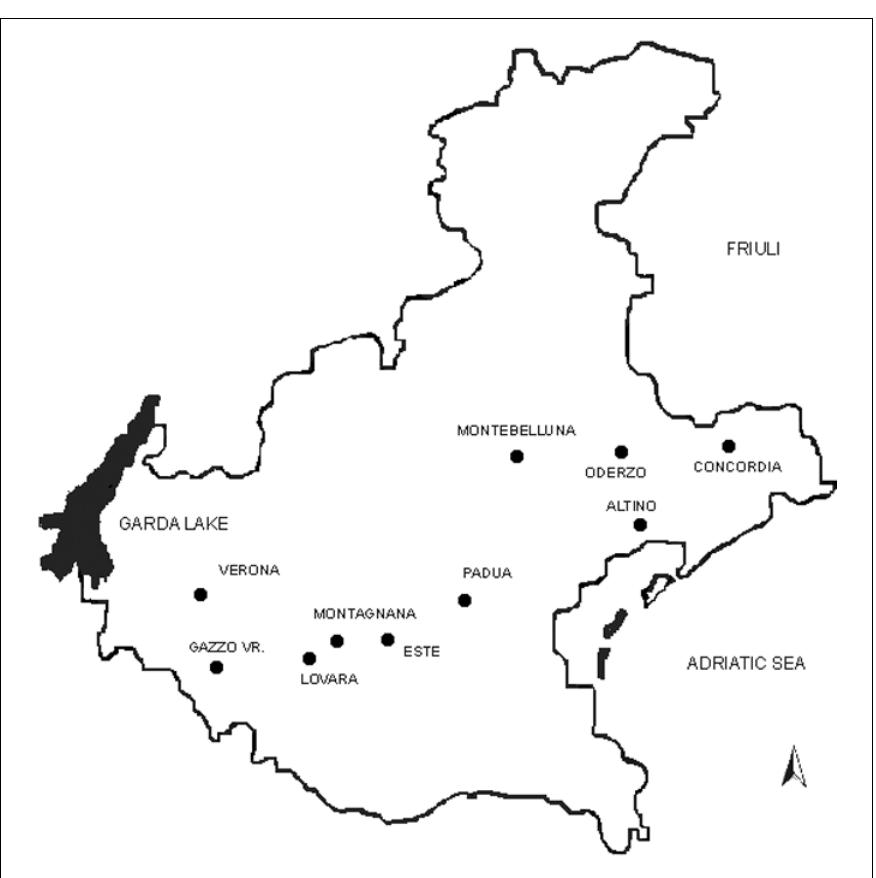
Figure 1. Map of the Veneto